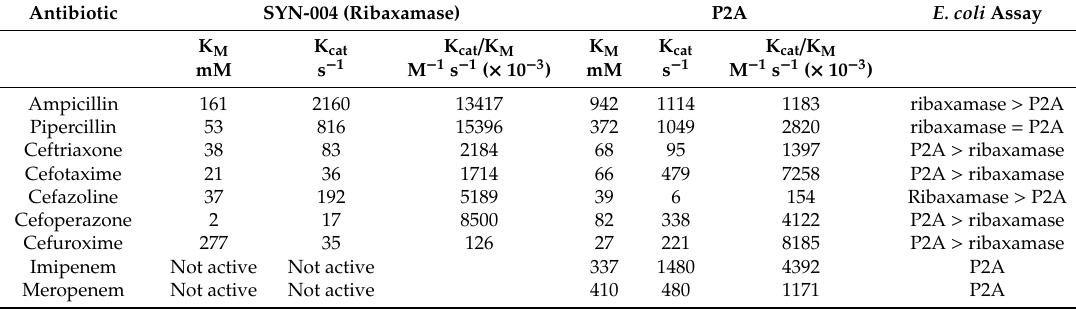
Table 1. Antibiotic degradation kinetics of ribaxamase and P2A. Steady ‐ state K M and k cat values for the indicated beta ‐ lactam antibiotics were determined by measuring substrate hydrolysis under initial rate conditions with Hanes linearization of the Michalis ‐ Menten equation. Relative antibiotic degradation efficiency based on the E. coli growth assay is displayed in the last column for comparison.